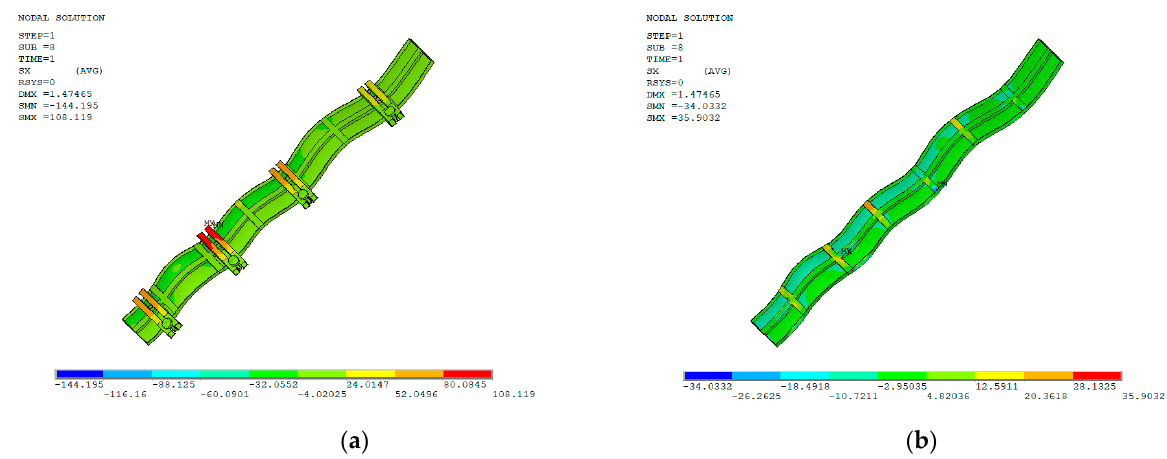
Figure 11. Stress nephogram along X -direction: ( a ) outside view; ( b ) inside view. Compared to the stress along the X -axis, the stress along the Y -axis was relatively uniform with little change. The maximum tensile stress of 58.0 MPa appeared in the middle of the edge rib between the first and second braces, while the maximum compressive stress of 94.3 MPa appeared on the edge rib of the formwork connected to the second brace. This indicates that the constraint effect of vertical ribs was prominent with a higher stress under lateral pressure of